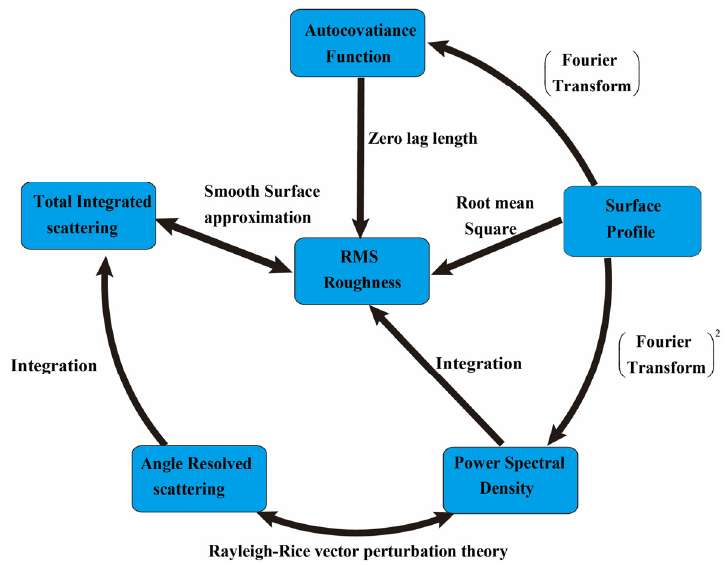
Figure 2. Relation between roughness and scattering parameters.